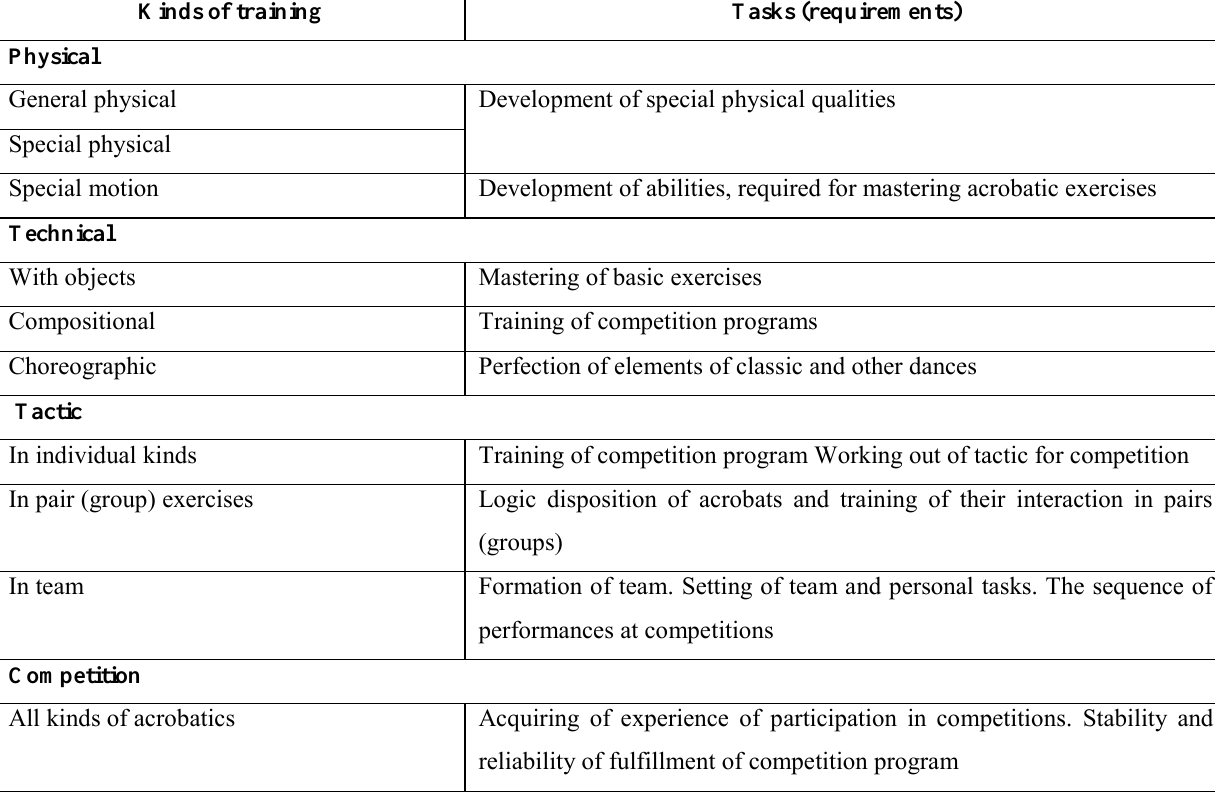
Main tasks in kinds of sport acrobatics (generalized and processed data of L.V. Savonik, 2008) Tasks